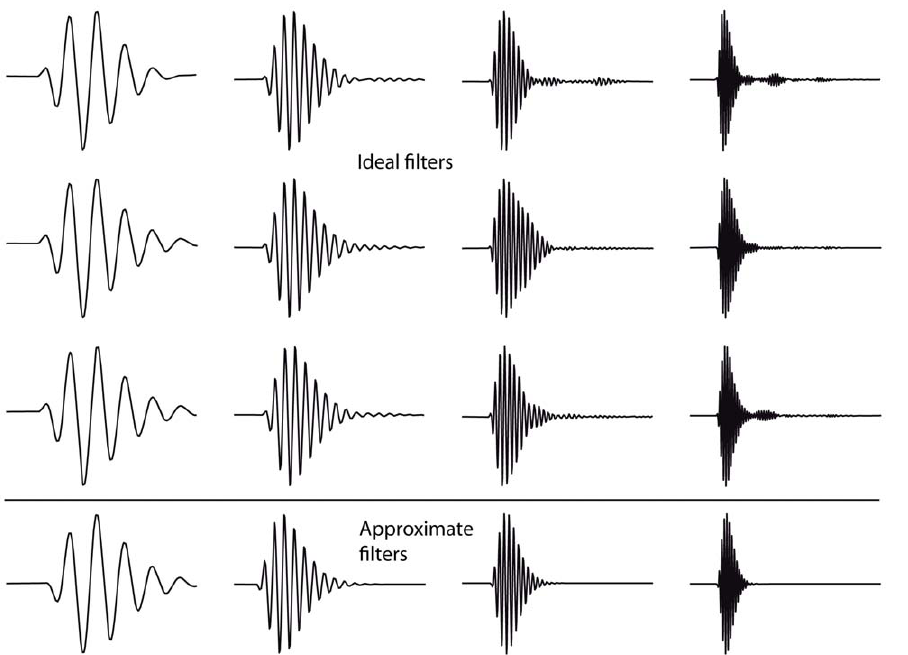
Figure 5. Examples of neural filters in the ideal and approximate model, which are band-pass filtered HRTFs. Each filter is 45 ms long. The central frequency varies between columns, while the HRTFs vary between rows in the first three rows. The resulting filters are similar to gammatone filters (shown in the last row), but not identical (see for example the differences in envelope within the first column, and within the last